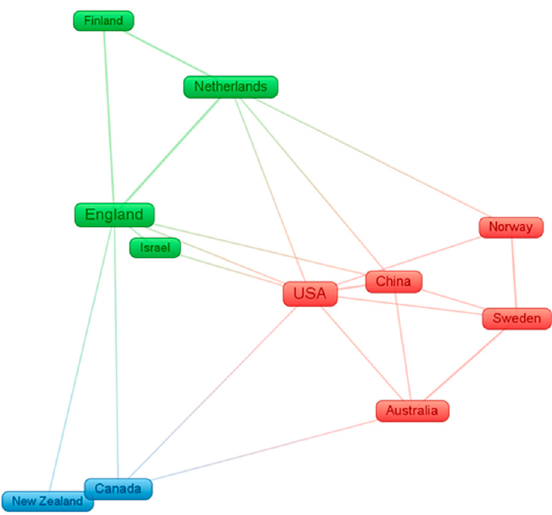
Figure 4. Cluster relationship network diagram of countries and regions.